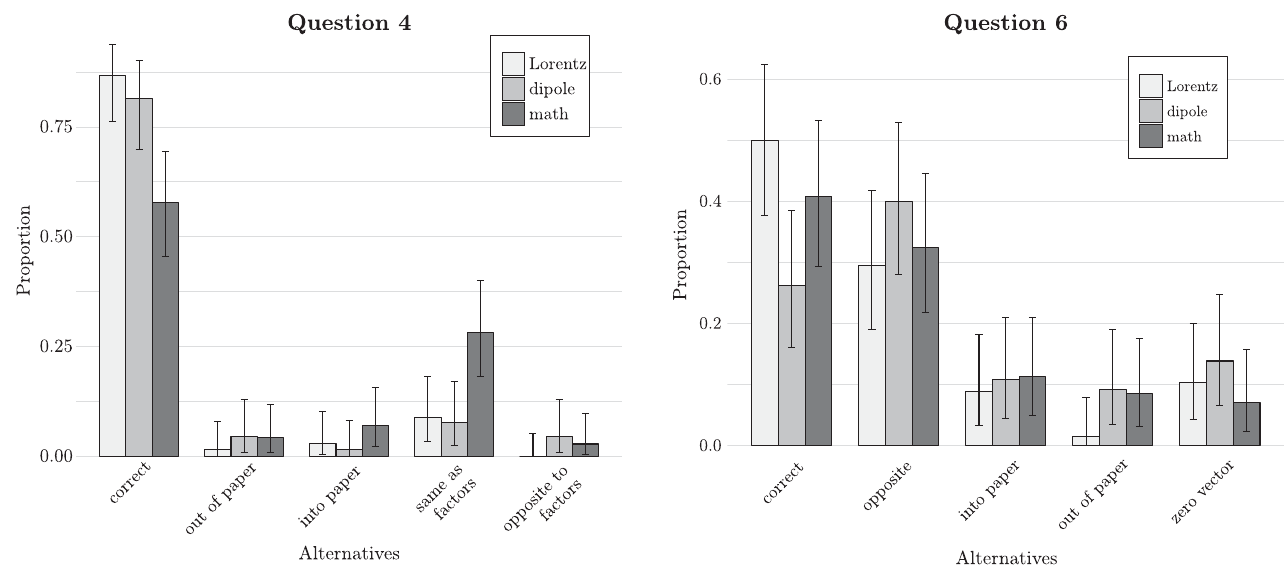
FIG. 6. Students ’ answers on question 6 about the cross product where the second factor pointed out of the plane of the paper. Error bars indicate the 95% confidence intervals based on the Clopper-Pearson method.